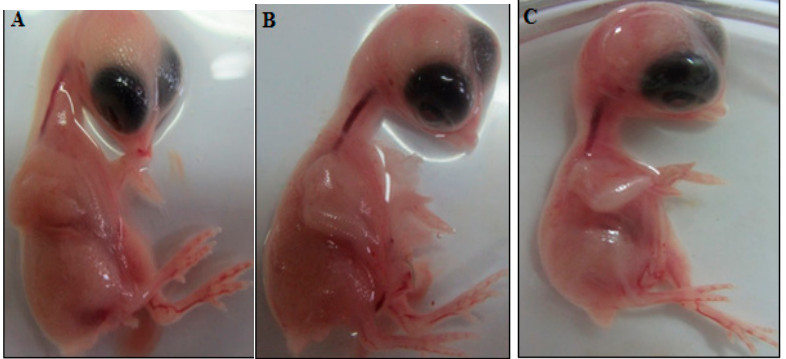
Figure 10. Morphometric changes: No disorder on development of chick embryo was seen. ( A ) Control, ( B ) 25 µg/mL, ( C ) 50 µg/mL.